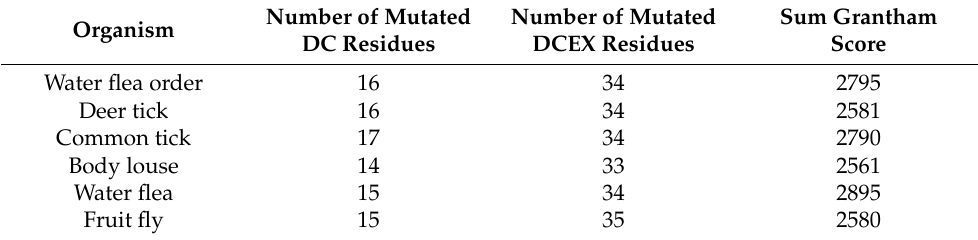
Table 2. Mutated direct contact (DC), DCEX residues and the Sum Grantham score of ectopara- site